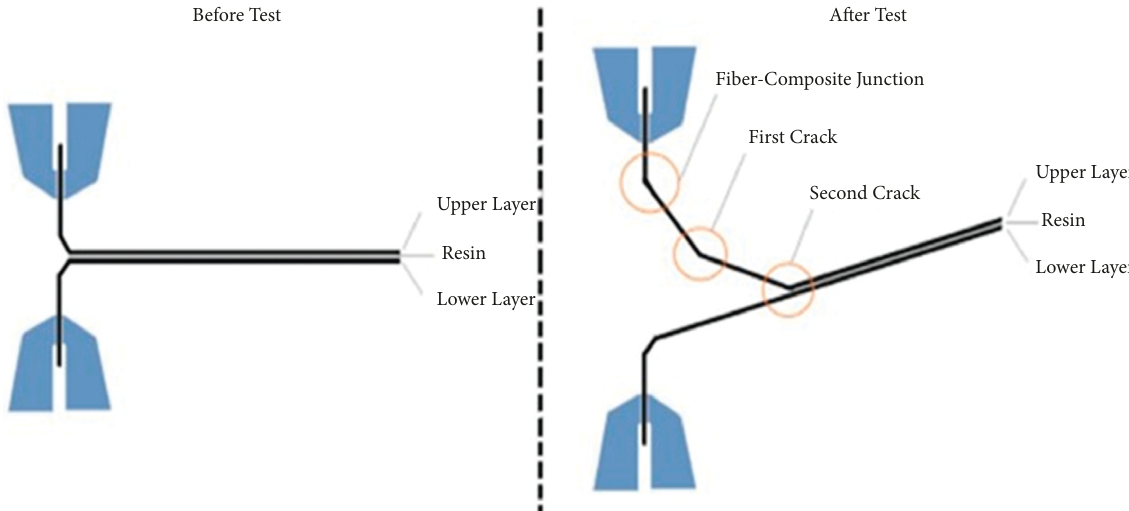
Figure 7: Schematic of samples before and after delamination